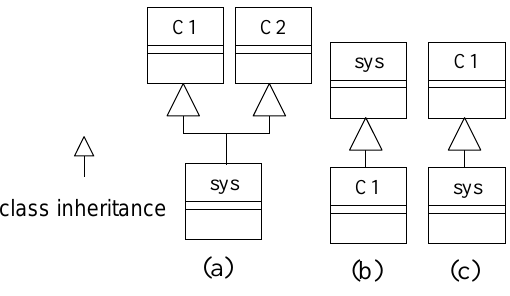
Figure 7. ( a ) Multiple inheritance, ( b ) Single inheritance, and ( c ) Single